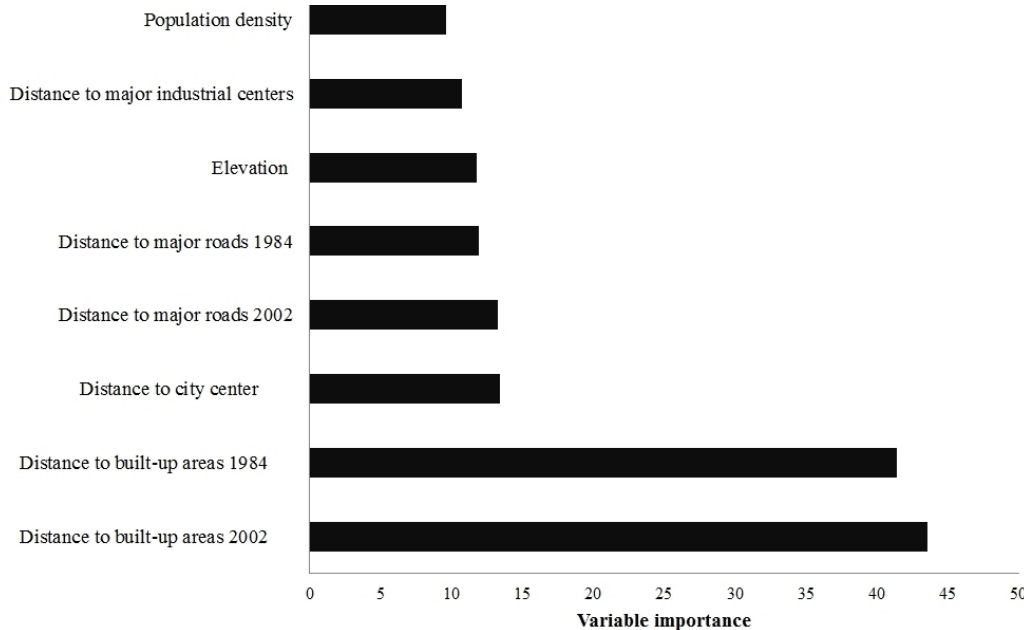
Figure 10. Variable importance for the “non-built-up to built-up” changes based on mean decrease